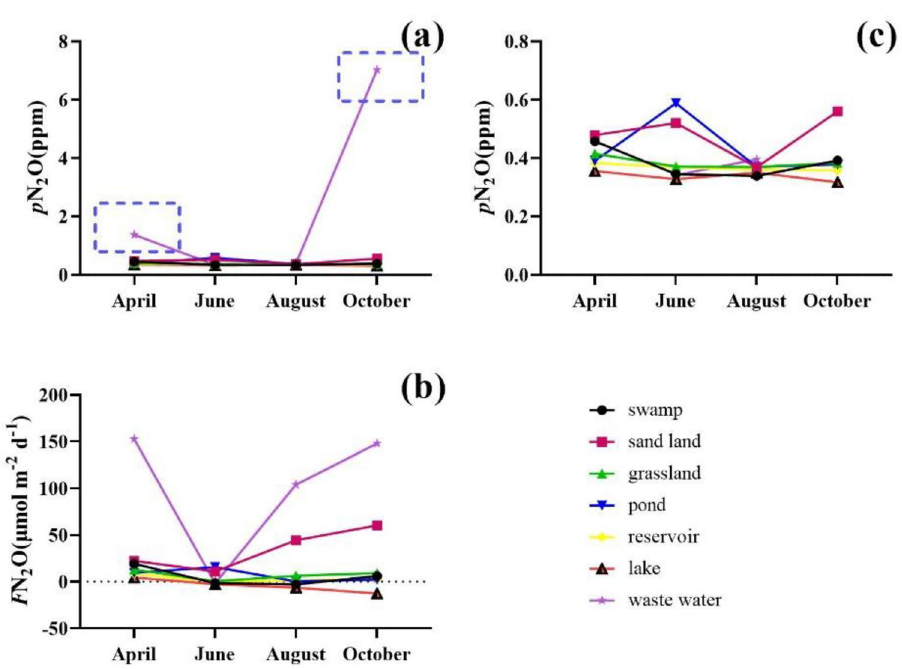
Figure 6. Temporal variation of p N 2 O ( a ) and F N 2 O ( b ) in the Xilin River in 2018 ( p N 2 O ( c ) except those points in the blue dotted